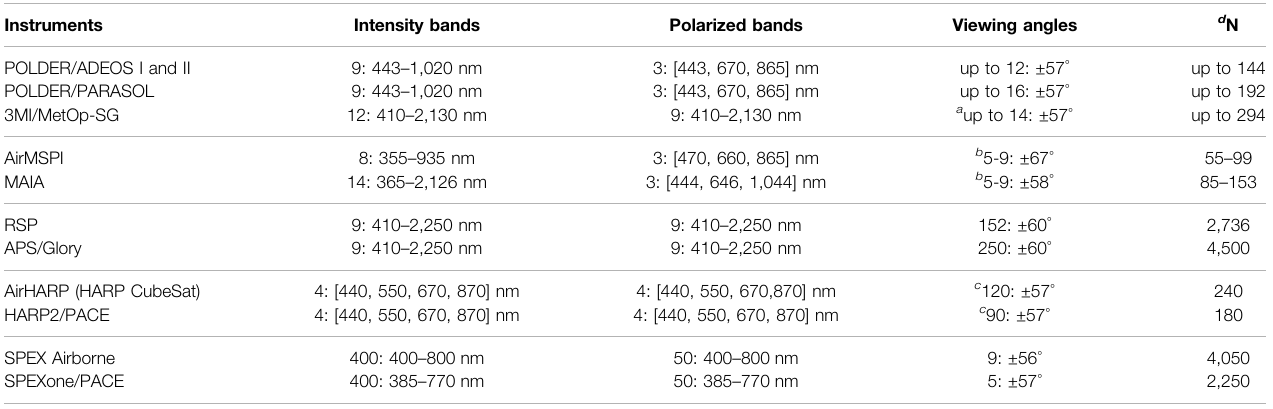
TABLE 1 | The number and range of the spectral bands and view angles for various MAP instruments. Instruments Intensity bands Polarized